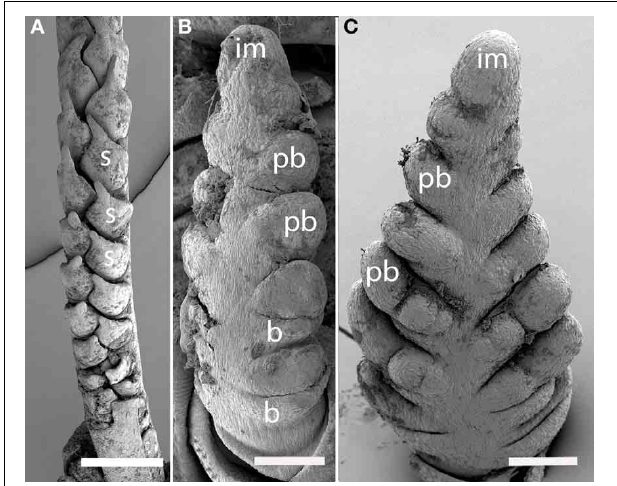
FIGURE 5 | Nassella filiculmis (Stipeae). (A,B) Early development, showing two-ranked nearly distichous branching. (C) Branch meristems enlarging on one side of the inflorescence. (D–F) Inflorescence becomes unilateral and terminal spikelet differentiates. im, inflorescence meristem; pb, primary branch; fm, floral meristem; g, glume; le, lemma. Scale bars: (A–C) , 100 µ m; (D–F) , 200 µ